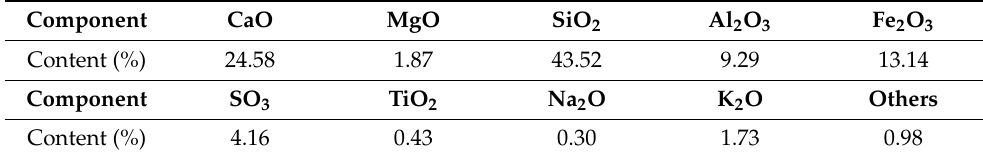
Table 2. Tested soil chemical